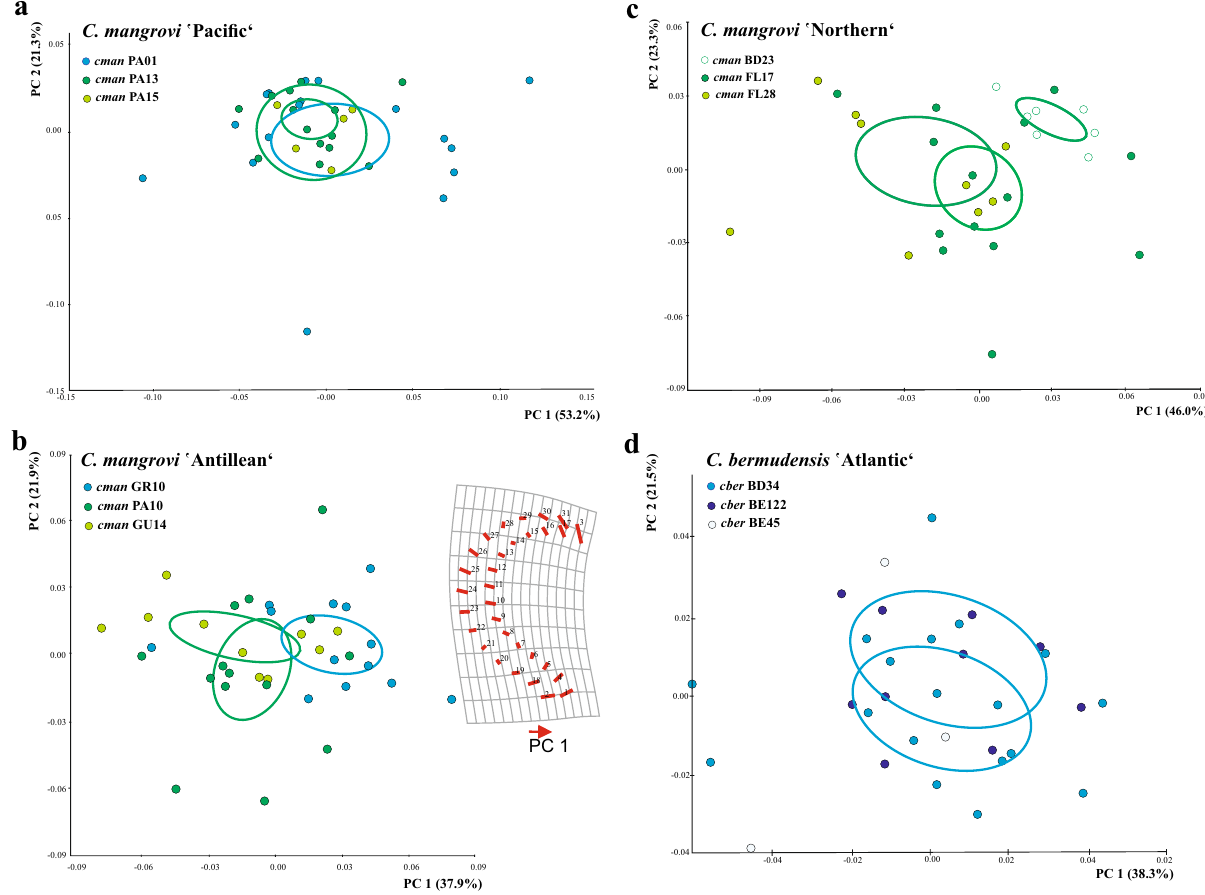
Figure 5. Claw shape within a genetic lineage. PCA scatter plot of specimens of ( a ) C. mangrovi ‘Pacific’ ( b ) C. mangrov i ‘Antillean’ ( c ) C. mangrovi ‘Northern’ and C. bermudensis ‘Atlantic’ with confidence ellipses for means (90% probability). Green colored points mark specimens sampled from mangroves and blue points stand for specimens originating from rocky